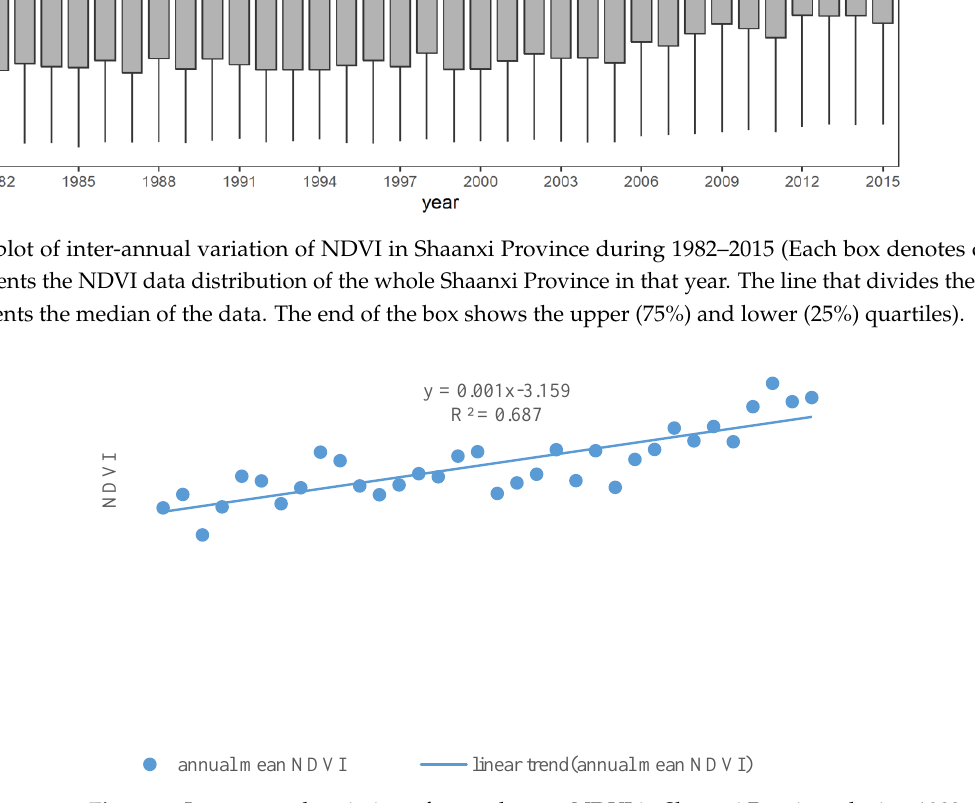
Figure 3. Inter-annual variation of annual mean NDVI in Shaanxi Province during 1982–2015 (The x -axis represents the year).